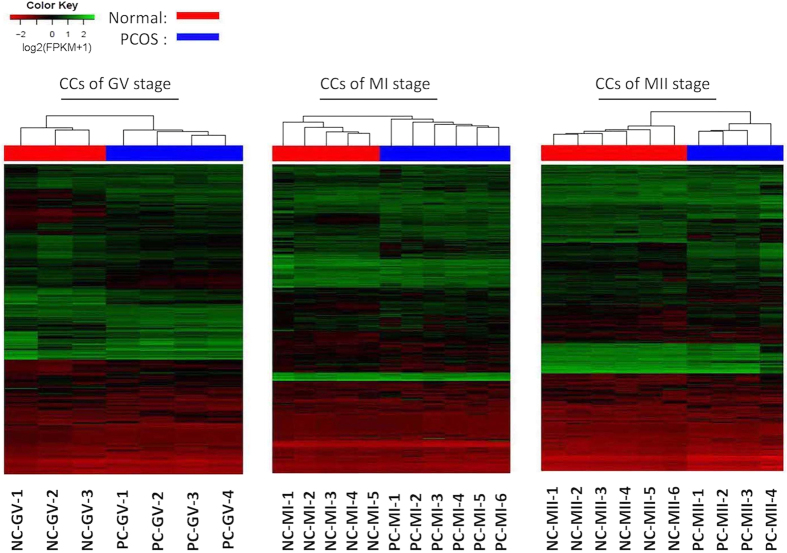
Heatmap of differentially expressed genes in CCs with and without PCOS at GV, MI, MII stage.Green corresponds to up-expressed genes; red corresponds to down-expressed genes. CCs, cumulus cells. NC-GV, CCs at GV stage from normal women; PC-GV, CCs at GV stage from women with PCOS; NC-MI, CCs at MI stage from normal women; PC-MI, CCs at MI stage from women with PCOS; NC-MII, CCs at MII stage from normal women; PC-MII, CCs at MII stage from women with PCOS.